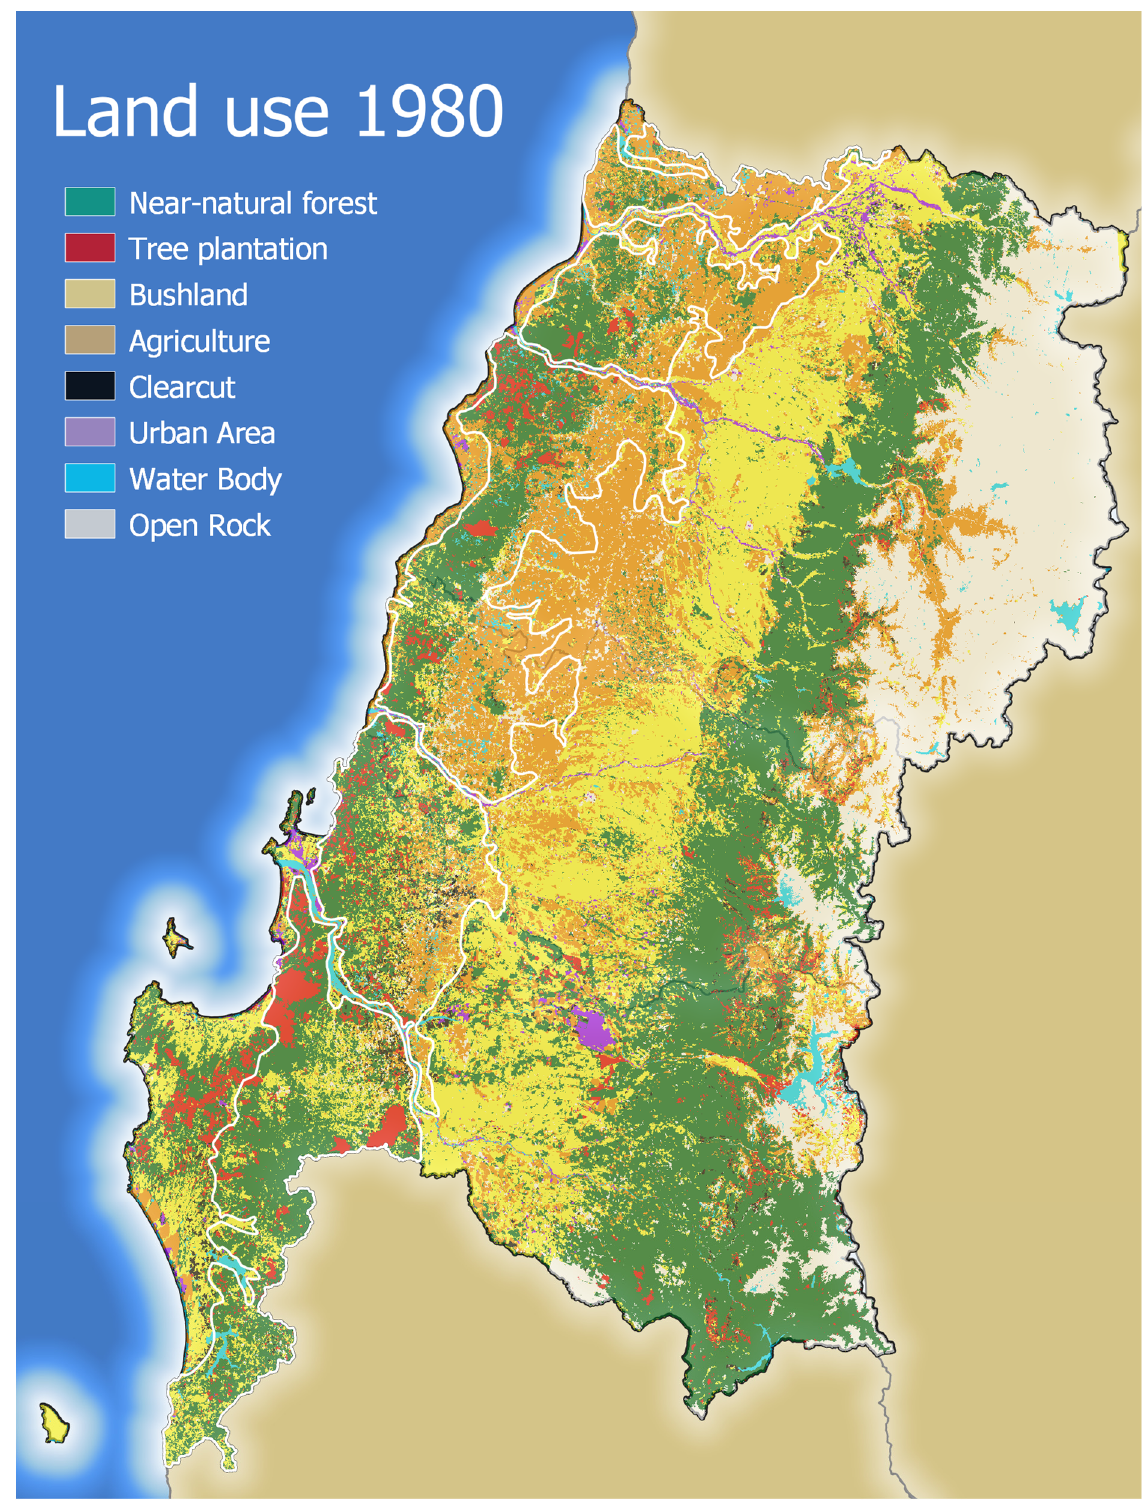
Figure A2. Land use map of study site in 1980.